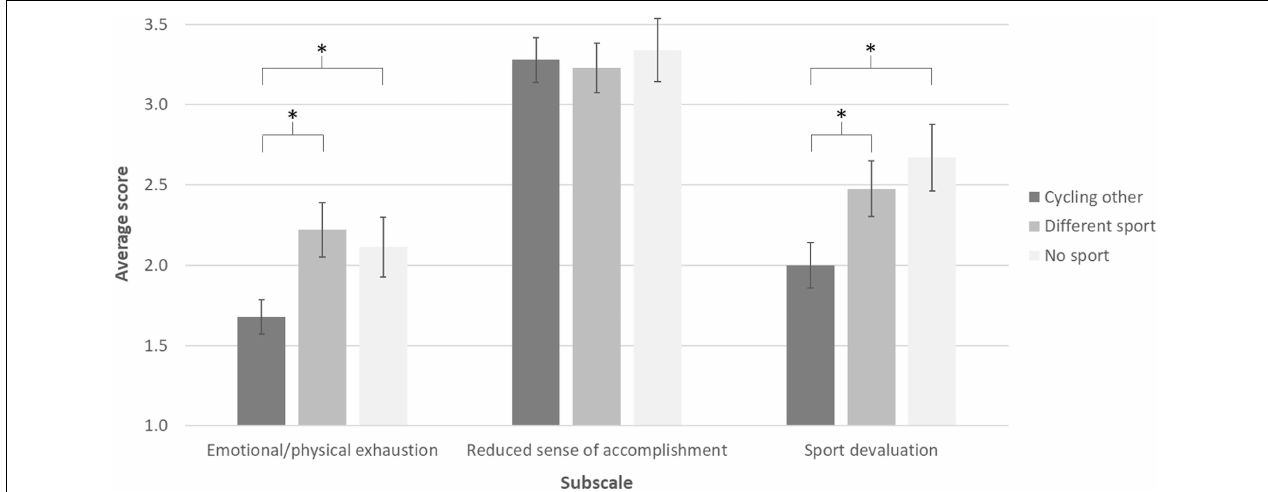
FIGURE 1 | Average scores of the three groups for the three subscales of the Athlete Burnout Questionnaire (ABQ); error bars show the standard error of the mean; ∗ p <